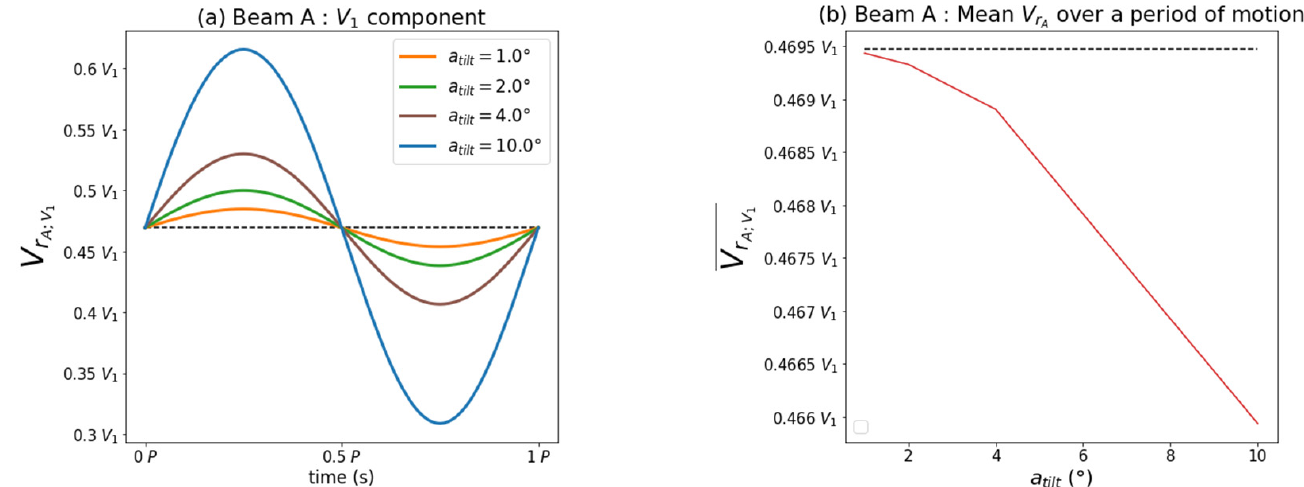
Figure 5. Response of the beam A to a sinusoidal motion of tilt T as a function of the incident wind component V 1 . ( a ) radial wind speed as a function of time relative to the period of the sinusoid. ( b ) Time-averaged value of the radial wind speed as a function of the sinusoid amplitude.